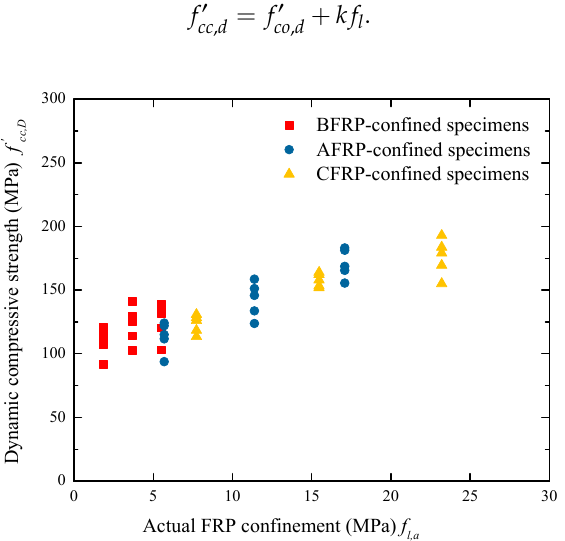
Figure 13. Relationship between the FRP confining stress and the dynamic compressive strength of FCHC.